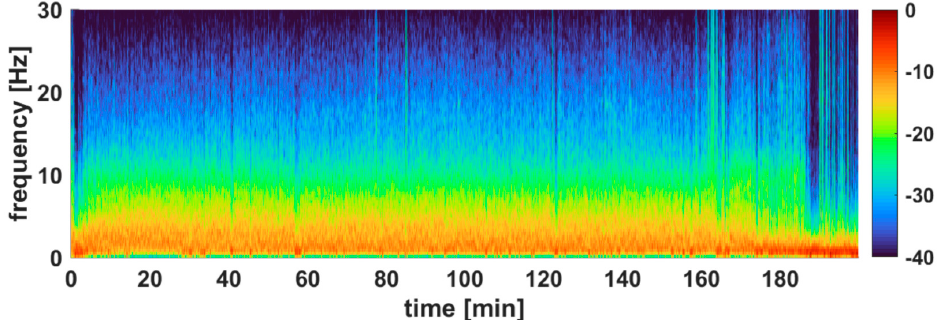
Figure 4. A reconstructed Density Spectral Array (DSA) example of a horse (soft-tissue surgery horse #4) is shown. The DSA was constructed with 5 s EEG segments from the entire anesthetic procedure. The artifact noise was removed using artifact subspace reconstruction. The DSA shows dominant slow wave activity as represented by the warm colors in the DSA. Towards the end of the DSA, it shifted toward cooler colors in the higher frequencies, and an increase in the power in the slower frequencies can be seen. All DSAs looked similar in the study horses.